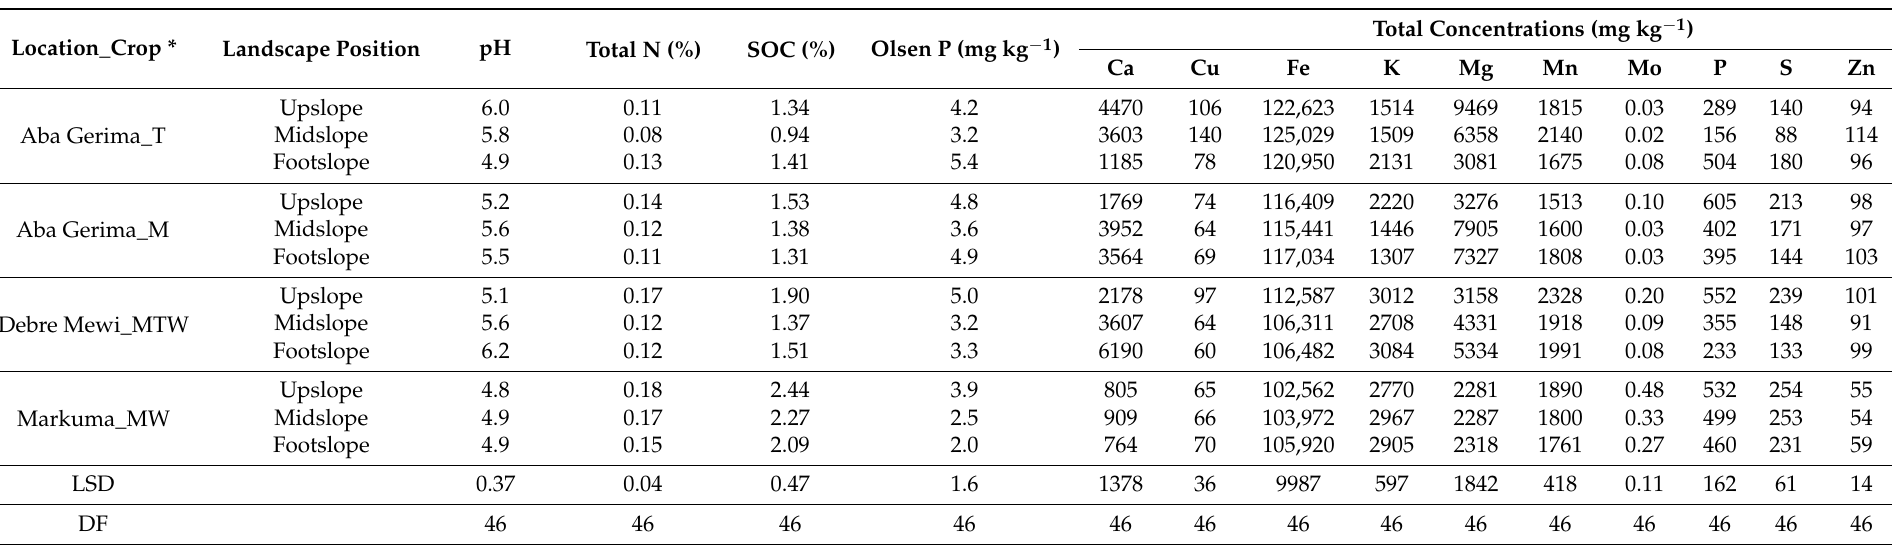
Table 1. Soil pH, Total Nitrogen, Soil Organic C, Olsen P, and total Ca, Cu, Fe, Mg, Mn, Mo, P, S and Zn. Shown are average values from 5 fields for sites in the same landscape position. Location_Crop * Landscape Position pH